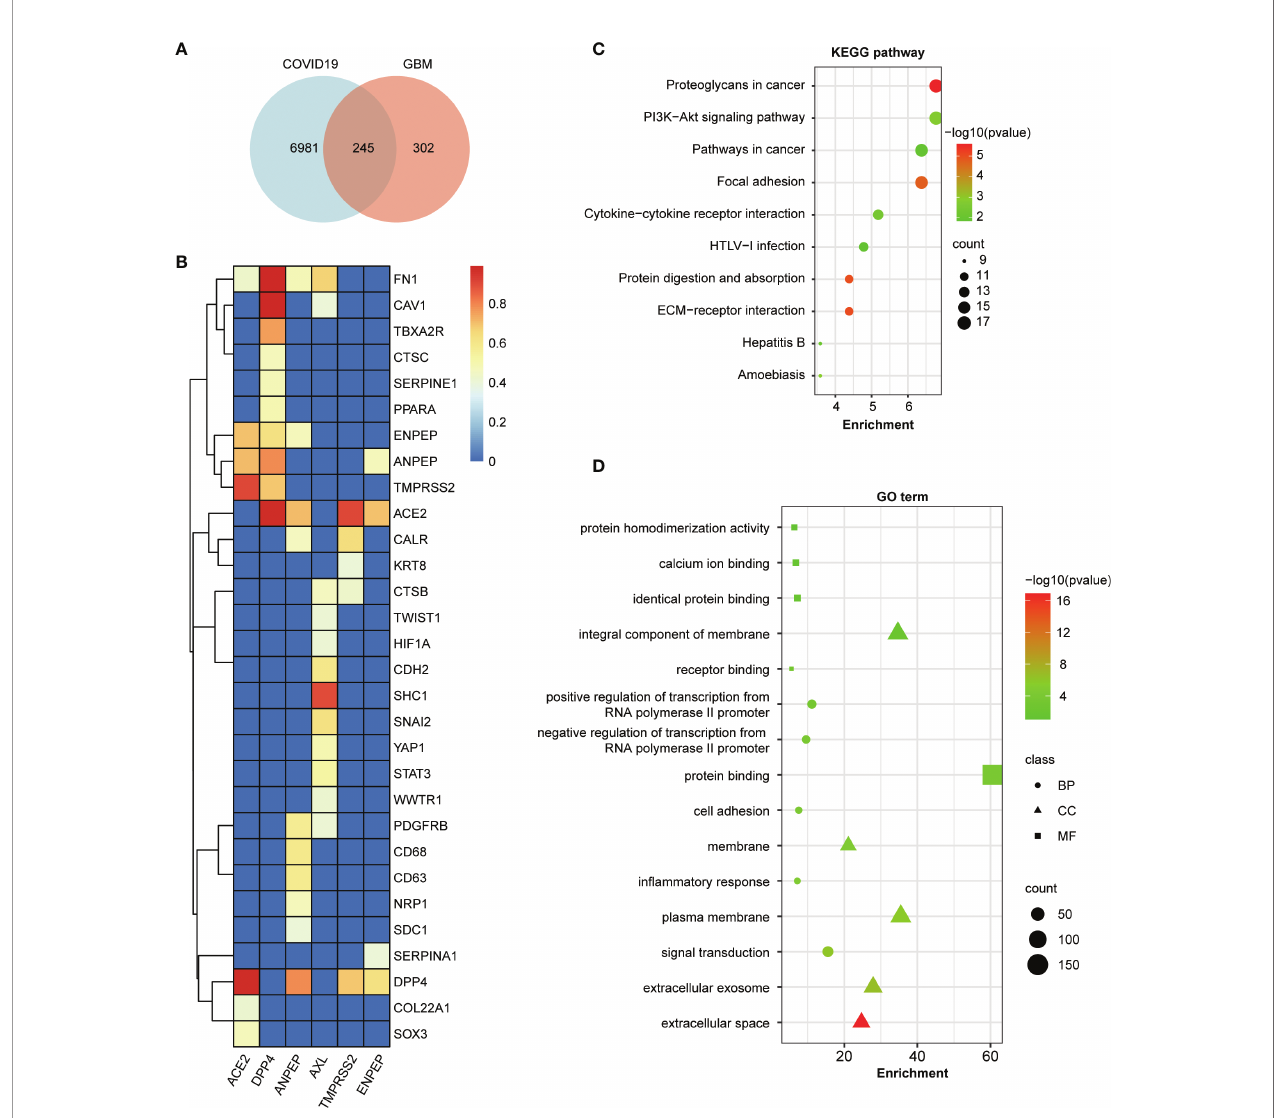
FIGURE 6 | Enrichment analysis of COVID-19-related genes and coronavirus receptor-related genes in GBM. (A) An intersection analysis between 7,230 COVID-19 genes downloaded from the Comparative Toxicogenomics Database (CTD) and the top 100 related genes of each receptor in GBM. A total of 245 common genes were identi fi ed between COVID-19 and coronavirus receptor-correlated genes in GBM. (B) Hierarchical clustering analyses of the direct interaction proteins across 245 common genes with coronavirus receptors. The color key represents the combined score calculated by the selected parameters of the homolog and experimentally determined interaction of the STRING program. Red, yellow and blue refer to high, medium and low combined scores, respectively. (C) Bubble chart for KEGG enrichment pathway analyses of common genes. (D) Bubble chart for GO functional and molecular processes of common